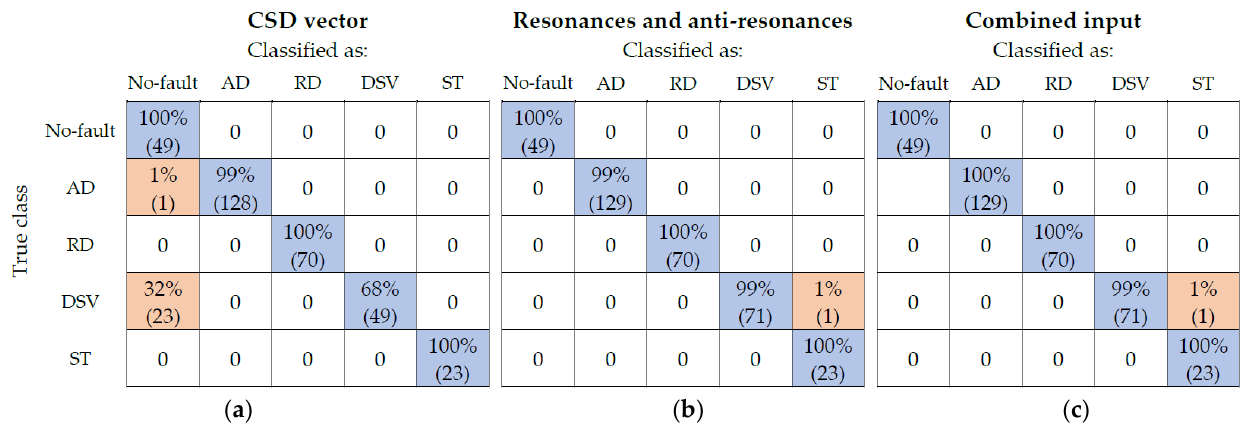
Figure 9. Confusion matrices for fault database classification (classification scenario 1) using the following as input: ( a ) CSD vector values, ( b ) resonance and anti-resonance points (frequency and amplitude) and ( c ) combined input.